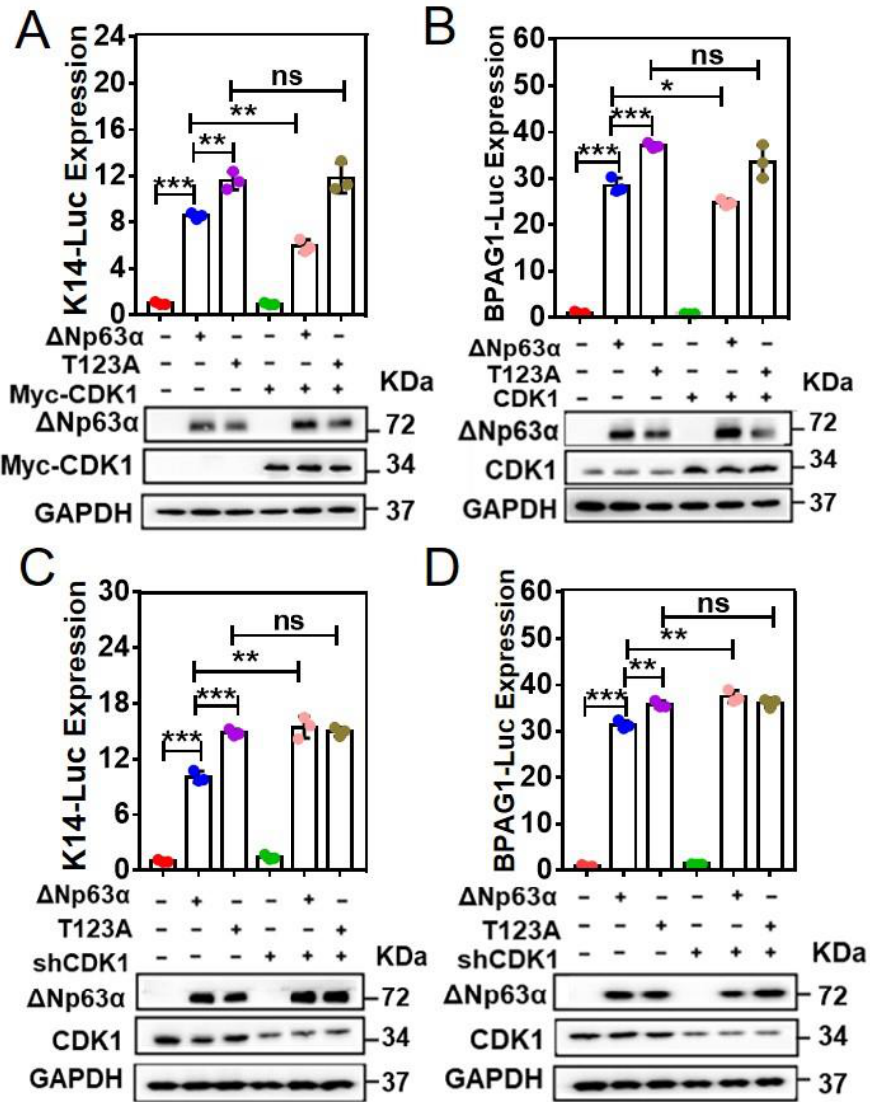
Figure 3. T123A mutation in ∆ Np63 α abrogates the inhibitory effect of CDK1 on ∆ Np63 α –mediated transcriptional regulation. ( A – D ), HEK293T cells were transfected with a mixture of K14-Luc or BPAG1-Luc and TK-Renilla, plus Flag- ∆ Np63 α or its T123A mutant and My-CDK1 or shCDK1#1 plasmids, as indicated. IB analyses were performed to detect expression of indicated proteins in parallel. The K14-Luc or BPAG1-Luc expression levels were normalized to Renilla activity and presented as means ± SD (n = 3). Two-tailed t -test was used for comparison between two groups; ***, p < 0.001; **, p < 0.01; *, p < 0.05; ns, nonsignificant.